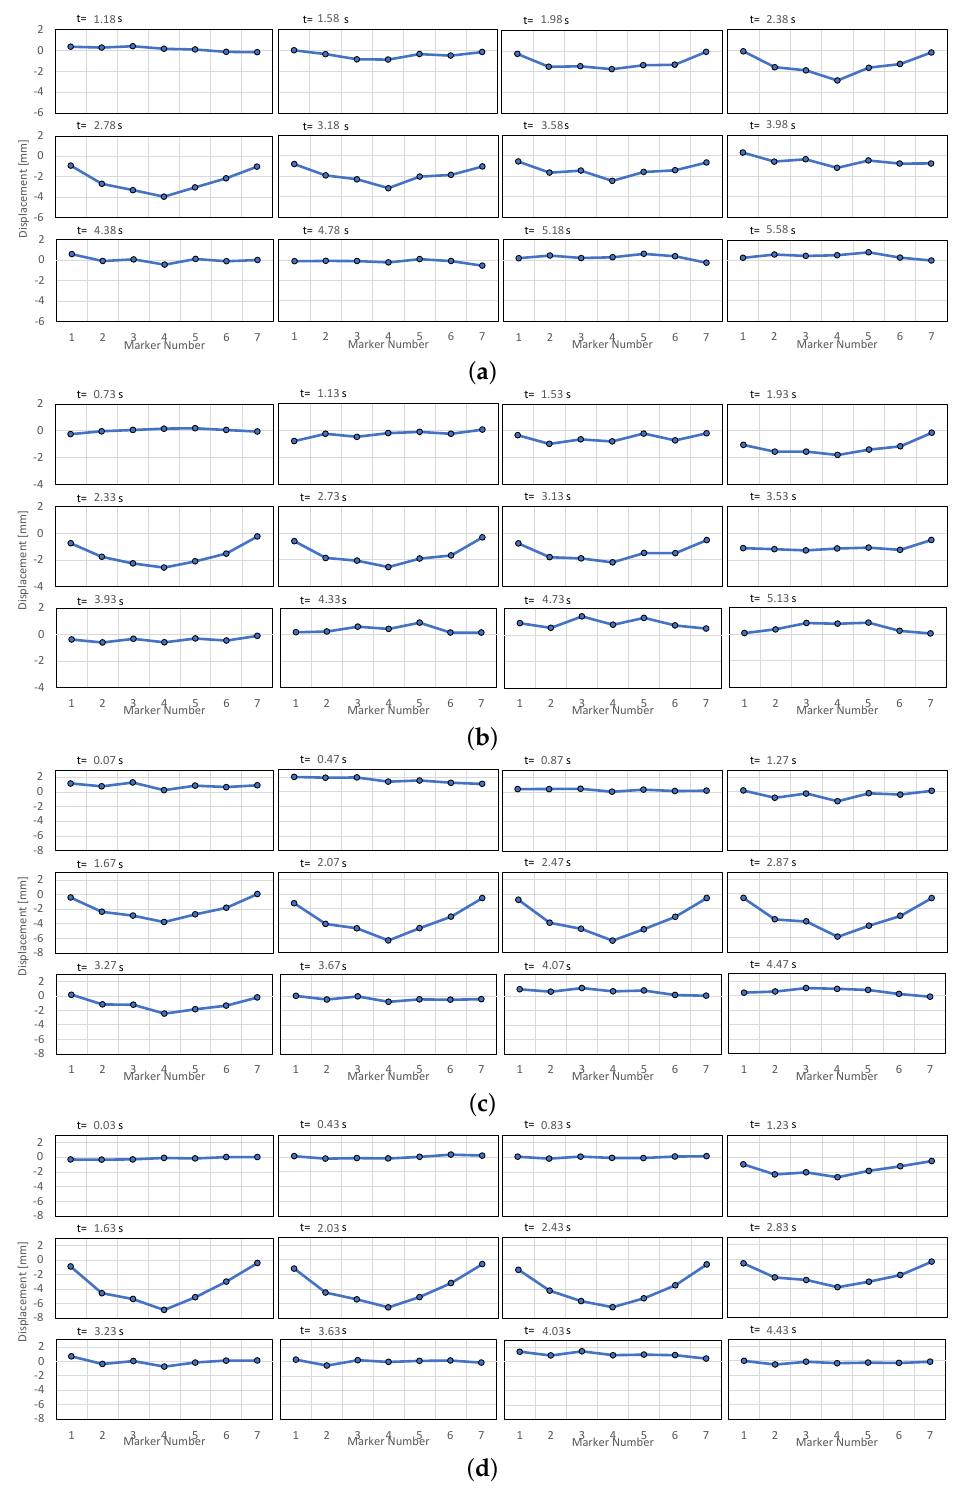
Figure 16. Bridge deck deflection at 16:01 ( a ), 16:12 ( b ), 16:18 ( c ), and 16:22 ( d ) Time offset follows the segment in Figure 15 with a 0.4 s interval between images that start just before the moment of excitation. The deflection shows a downward movement during a large vehicle’s pass with the largest displacement consistently observed towards the center of the bridge